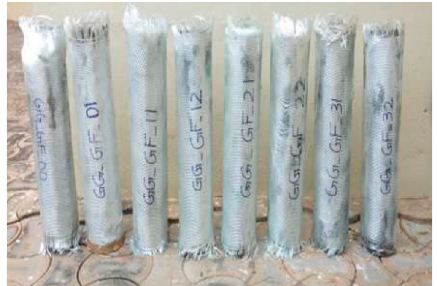
Figure 12: Column specimens wrapped with GFRP.